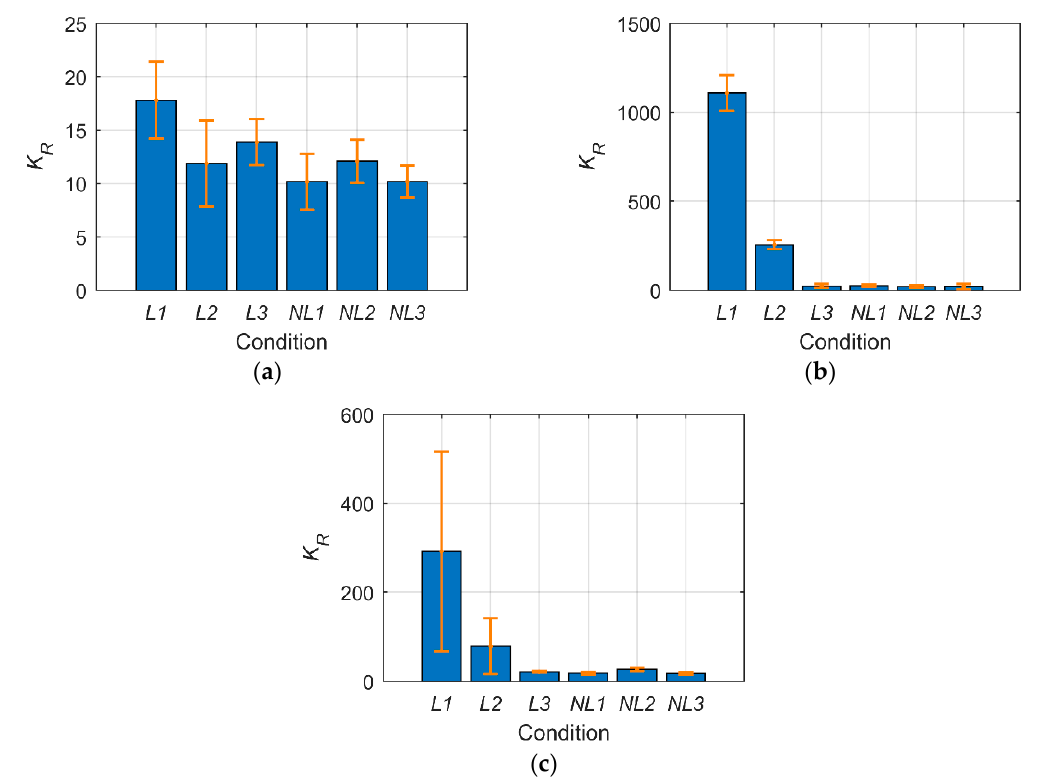
Figure 4. Mean kurtosis values ( K R ) in Test-1 (± standard deviation ( σ R ) intervals are indicated by the orange vertical bars), for sensors: ( a ) radial accelerometer sensor (Ard); ( b ) axial accelerometer sensor (Aax); ( c ) hydrophone sensor (Hyd).